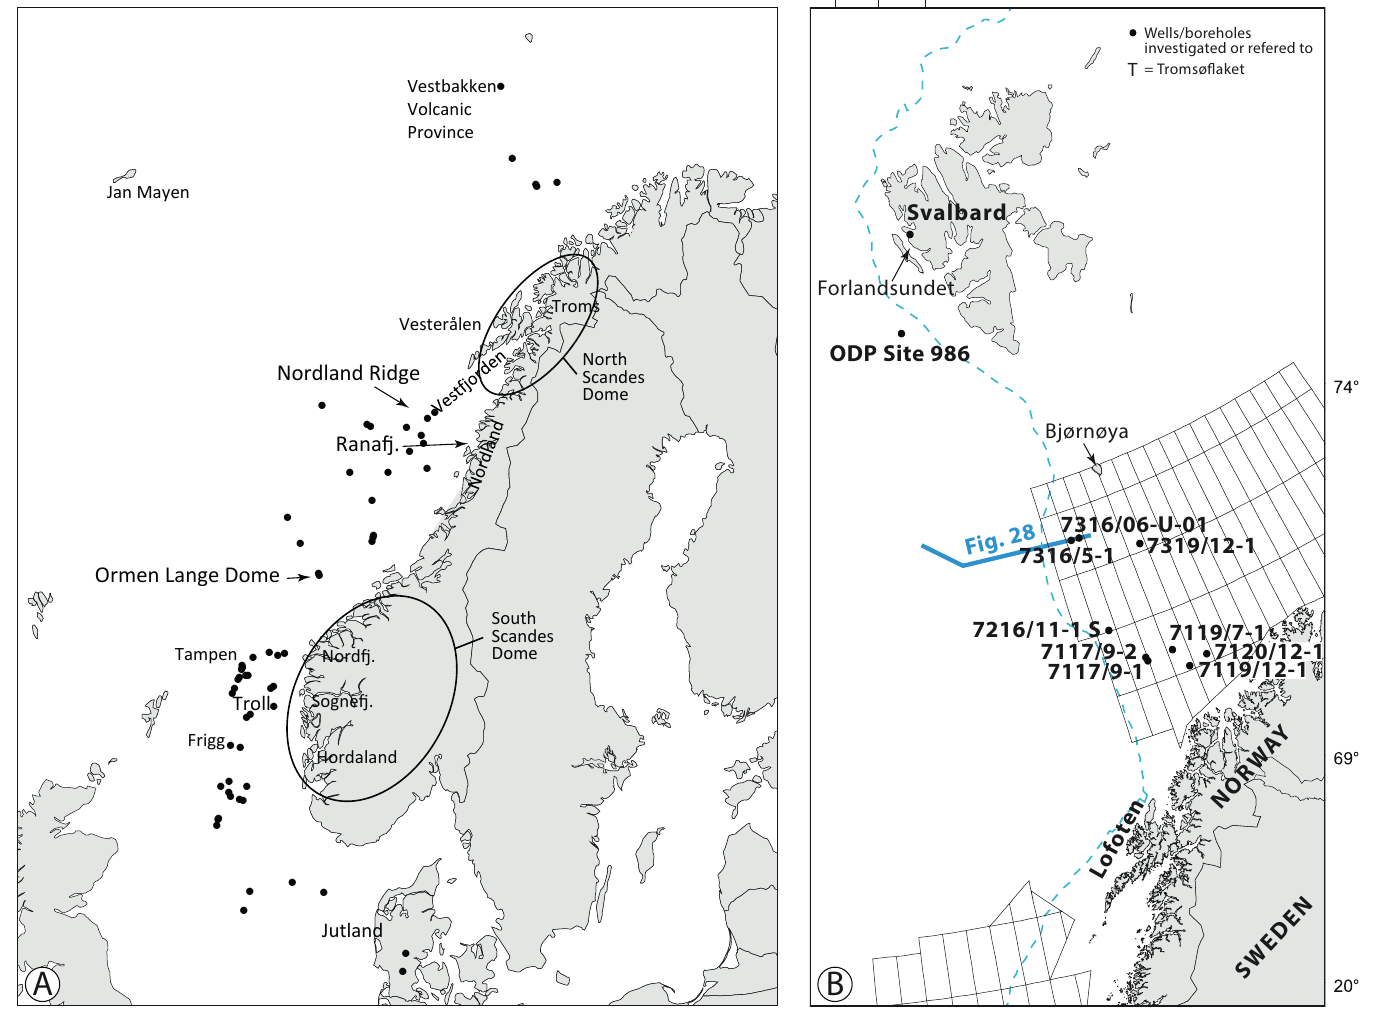
Figure 1. (A) Location map. Wells, boreholes and outcrop re-analysed and re-dated by the NPD are shown in black dots. (B) Wells, boreholes, outcrop and seismic profile in the western Barents Sea and Svalbard (modified after Eidvin et al., 2014). Fig. 1